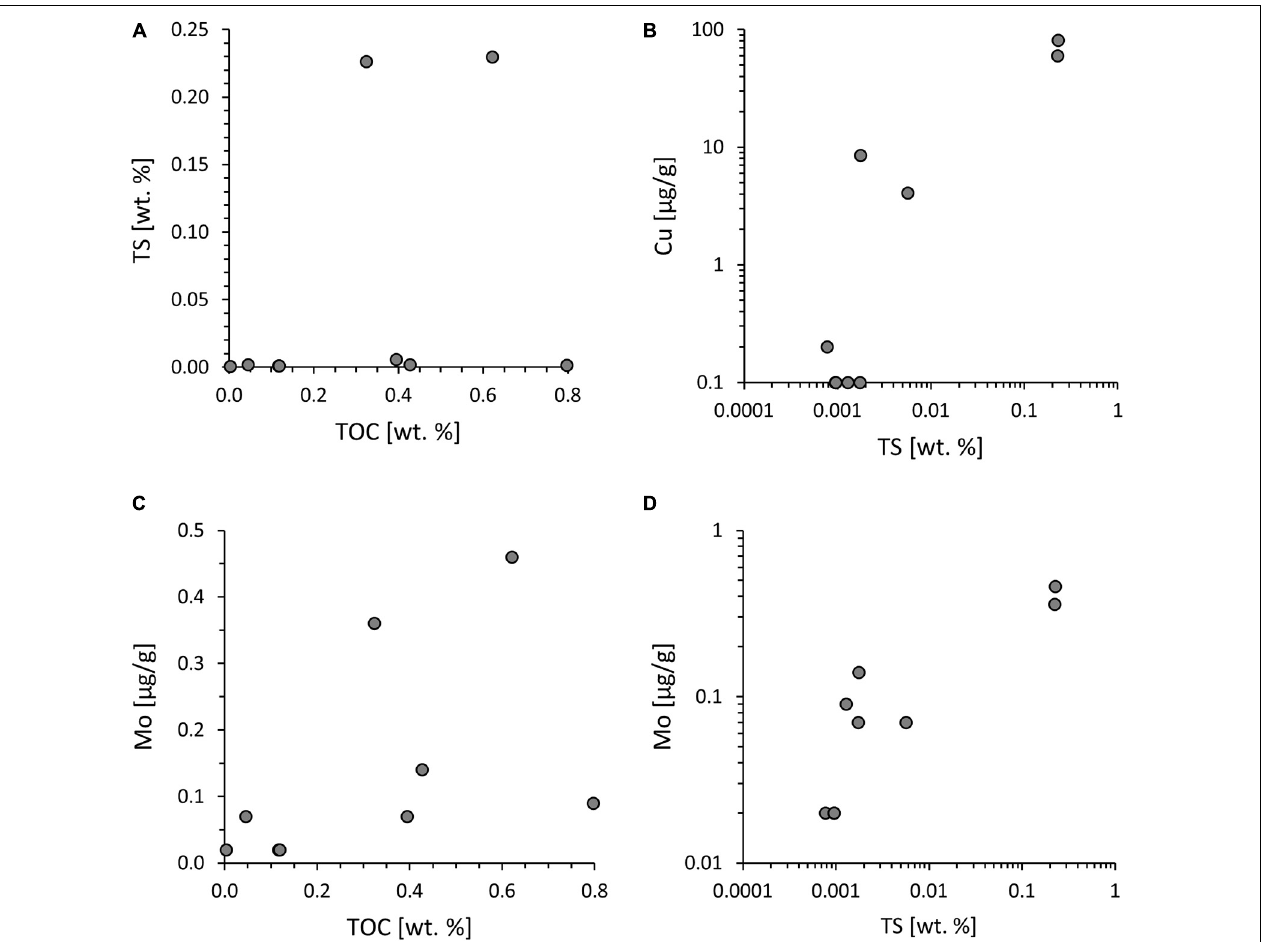
FIGURE 4 | Redox and hydrothermal alteration indicators. (A) Total sulfur (TS) vs. total organic carbon (TOC), showing no correlation. (B) Cu vs. TS. Given previous observations of chalcopyrite in these rocks (Rosing, 1999), the covariance between Cu and TS suggests a hydrothermal source of sulfur. (C) Mo vs. TOC, showing no correlation, counter to what is commonly observed in unaltered sedimentary rocks (Wilde et al., 2004). (D) Mo vs. TS, indicating that Mo may have been introduced by hydrothermal fluids along with Cu and sulfur.